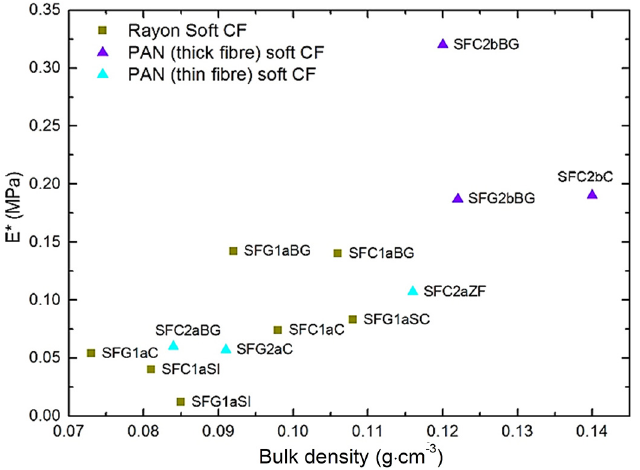
Figure 5. Elastic modulus values of soft CFs, calculated from Equation (6), as a function of bulk density. The symbols have the same meaning as in Figure 3.